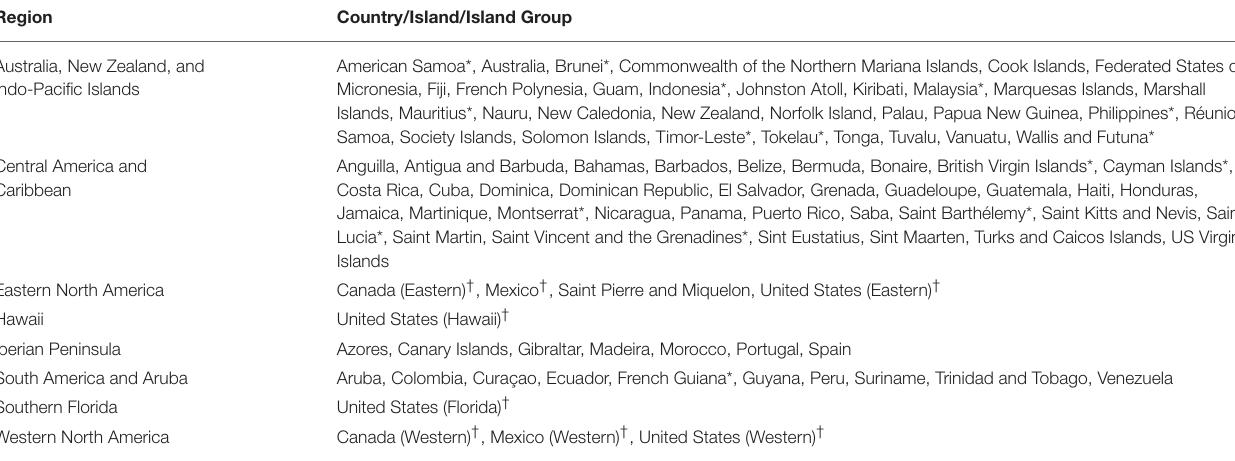
TABLE 1 | Locations with occurrences of monarchs. Region Country/Island/Island Group